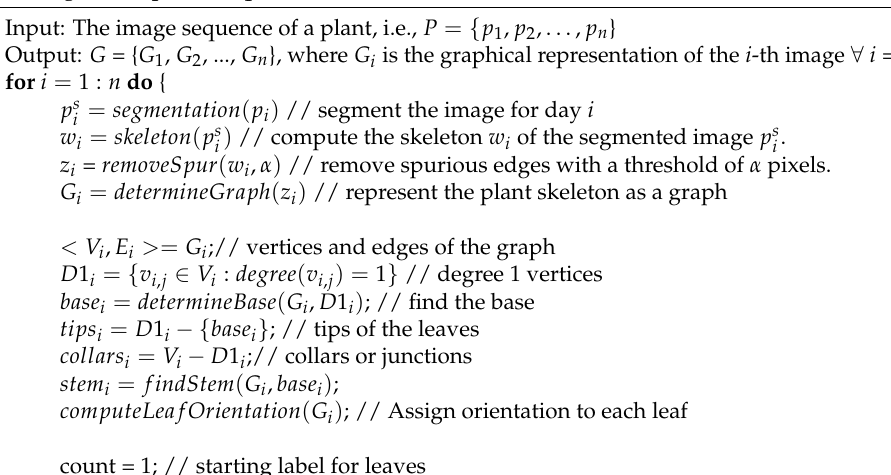
Algorithm 1 Plant architecture determination: produces a graphical representation of all the images of a plant sequence to detect the leaves and stem.